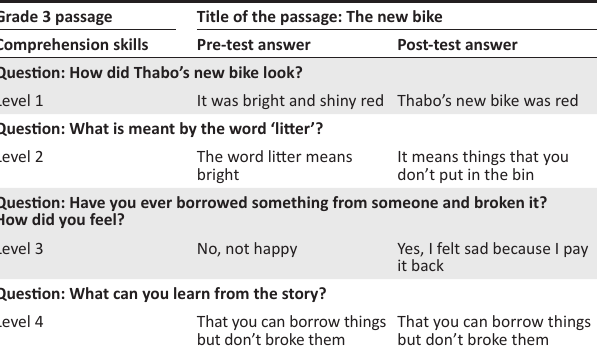
TABLE 4: L4’s written pre-test and post-test responses. TABLE 5: L5’s written pre-test and post-test